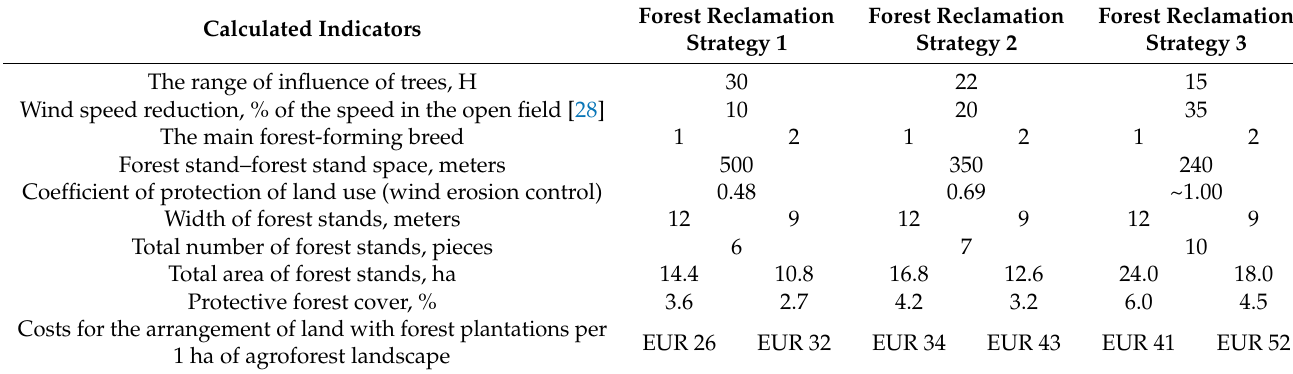
Table 2. Bioengineering modeling and capital intensity of measures for land use development by forest stands of the steppe zone of the south of the Russian Plain (based on 400 hectares of land use). Calculated Indicators